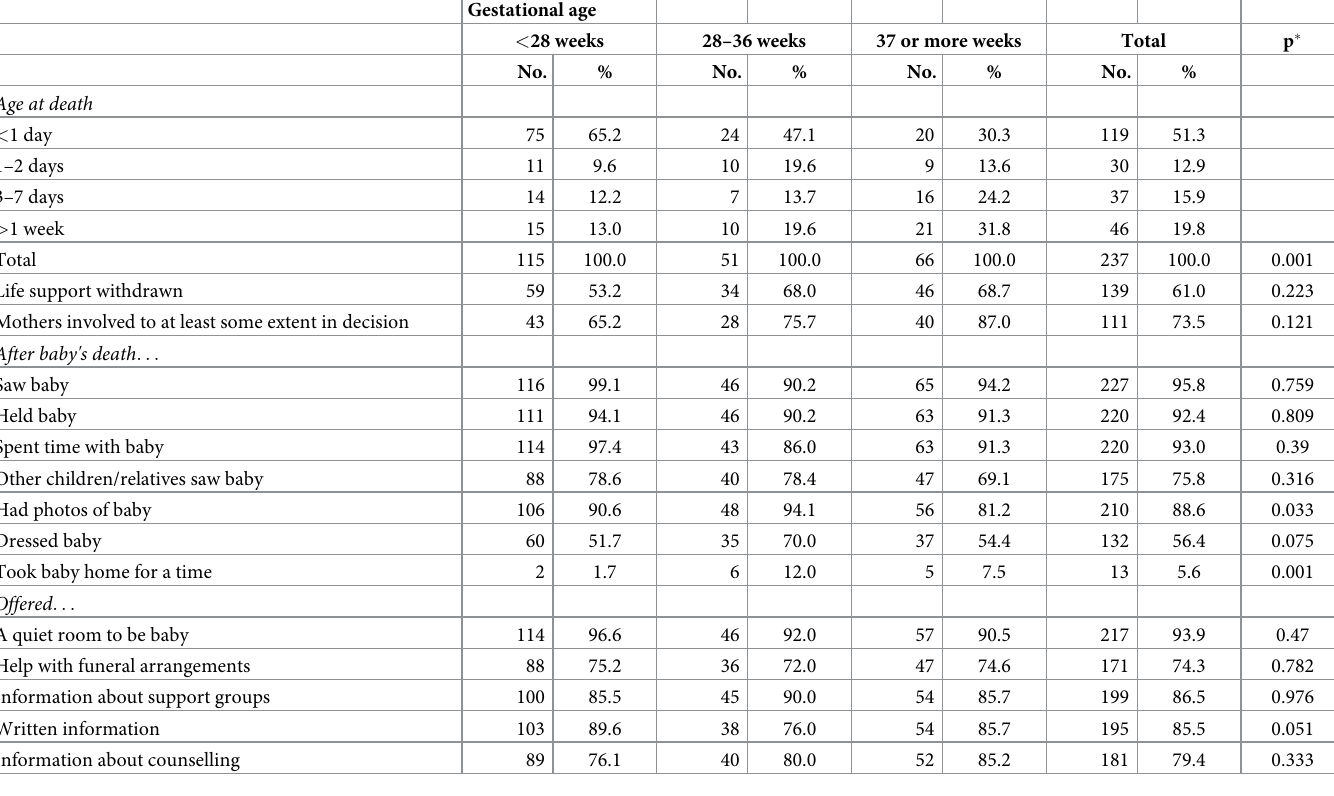
Table 5. Care and interaction following the baby’s death by gestational age